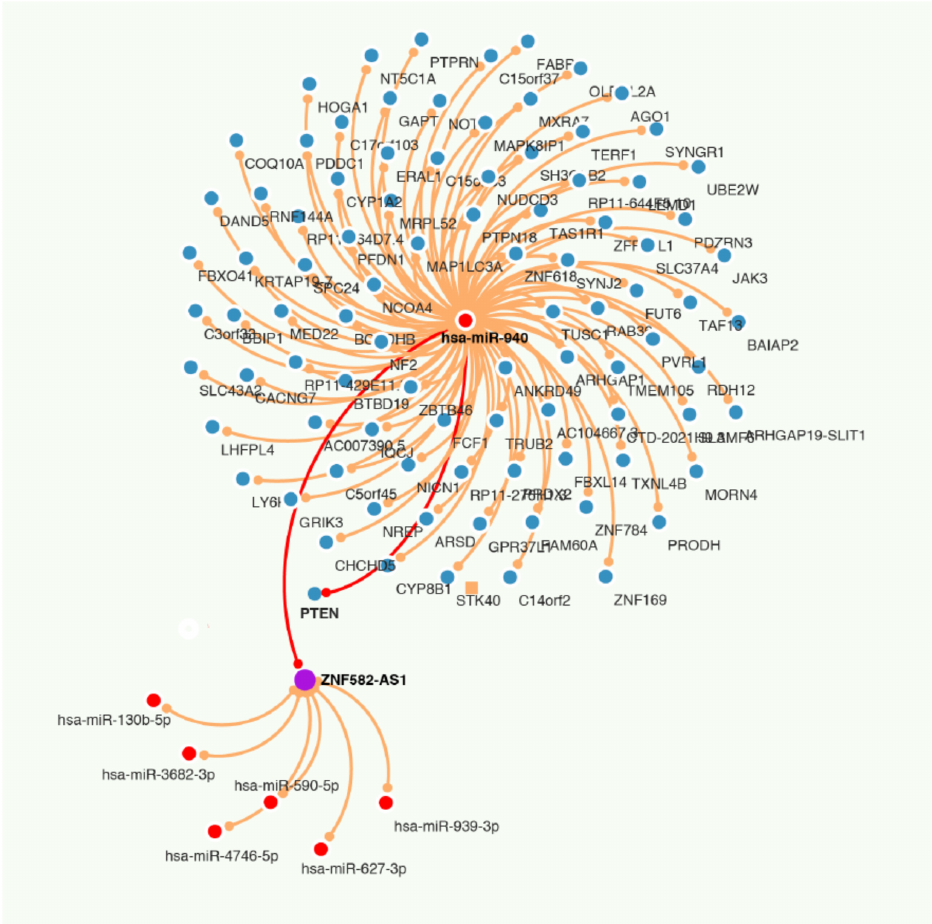
Figure 6. RNA network among lncRNA ZNF582-AS1 , miRNA has-miR-940, and mRNA PTEN. We used an online database (ChIPBase v2.0) to predict the transcription factors for ZNF582-AS1 , chr19:56 , 393 , 312-56 , and 414 , 800 (GRCh38/hg38) , and the online tool sug- gested five potential candidates in breast cancer cell lines, namely CTCF, KDM5B, HIF1A, ARNT, and NRF1 (Supplementary Table S6). The transcriptional start site (TSS) of ZNF582-AS1 is located at chr19:56393655. The binding sites predicted for HIF1A, ARNT, and NRF1 were in the regions of chr19:56393150-56393909, chr19:56393174-56393888, and chr19:56393152-56393920, respectively, all of which included TSS, suggesting that their binding to ZNF582-AS1 may suppress its expression.